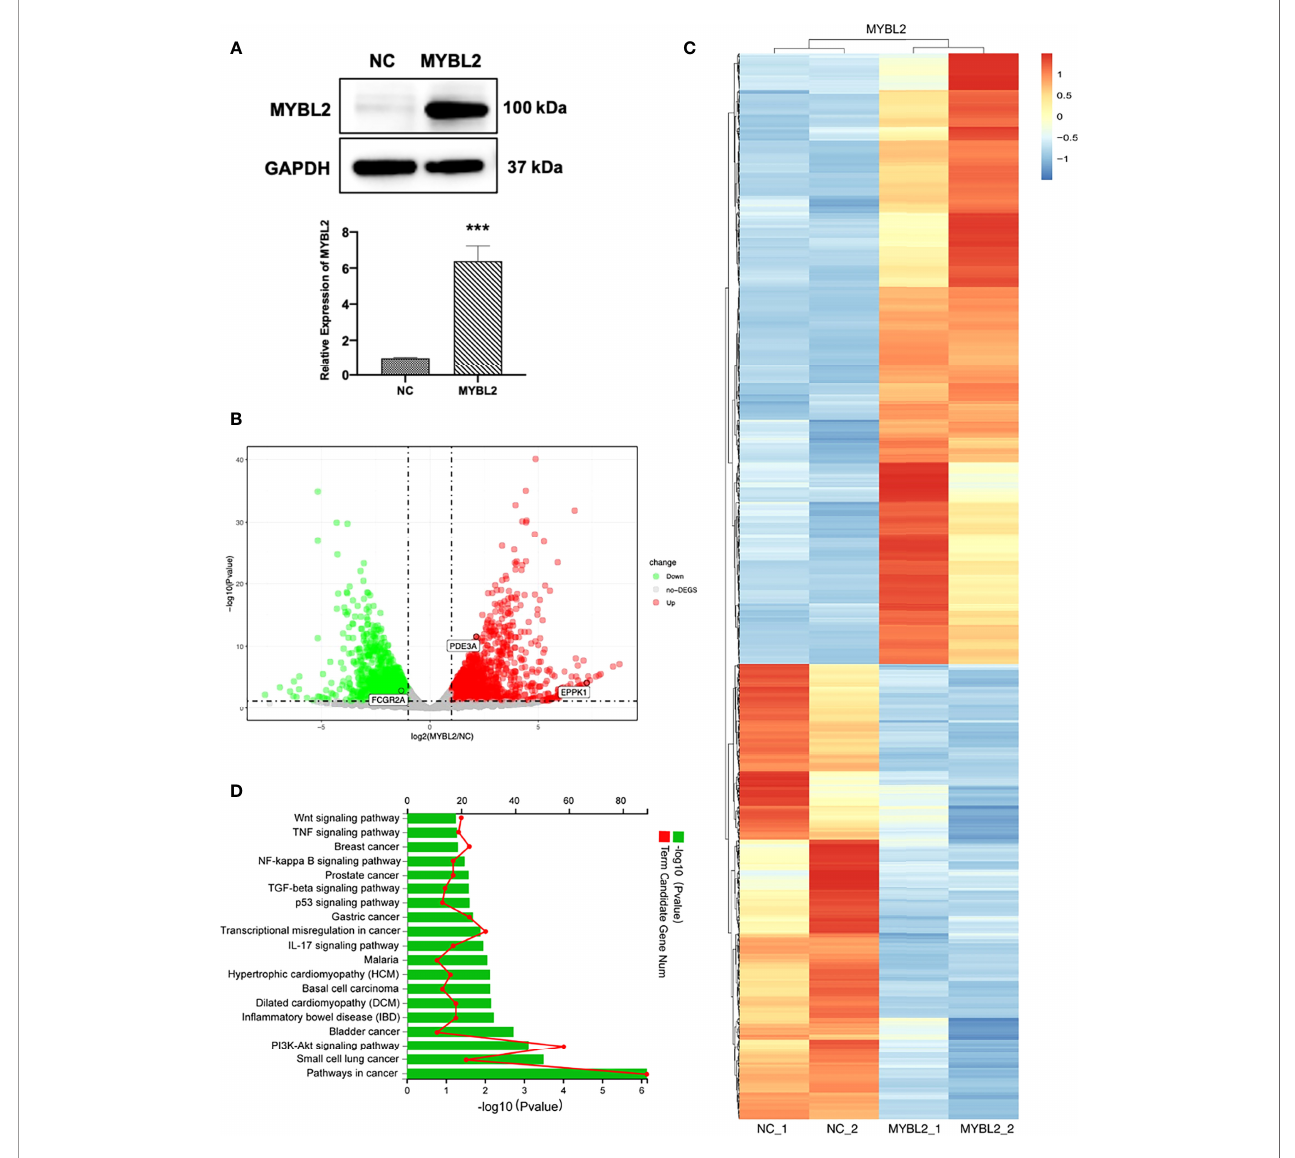
FIGURE 5 | Distinct genetic pro fi ling of MYBL2. (A) Western blot of MYBL2 in A2058 cells with control or MYBL2 overexpression. (B) Volcano plot showing differential gene expression (1,874 genes, FDR-corrected p -value < 0.05) in A2058 cells after overexpression of MYBL2. With ≥ 2-fold change cutoff, 810 genes were relatively downregulated and 1,064 genes were upregulated. (C) Heatmap of A2058 cells with stable MYBL2 overexpression. (D) KEGG pathway enrichment analysis (representative pathways) of genes in A2058 cells with stable MYBL2 overexpression. *** p <